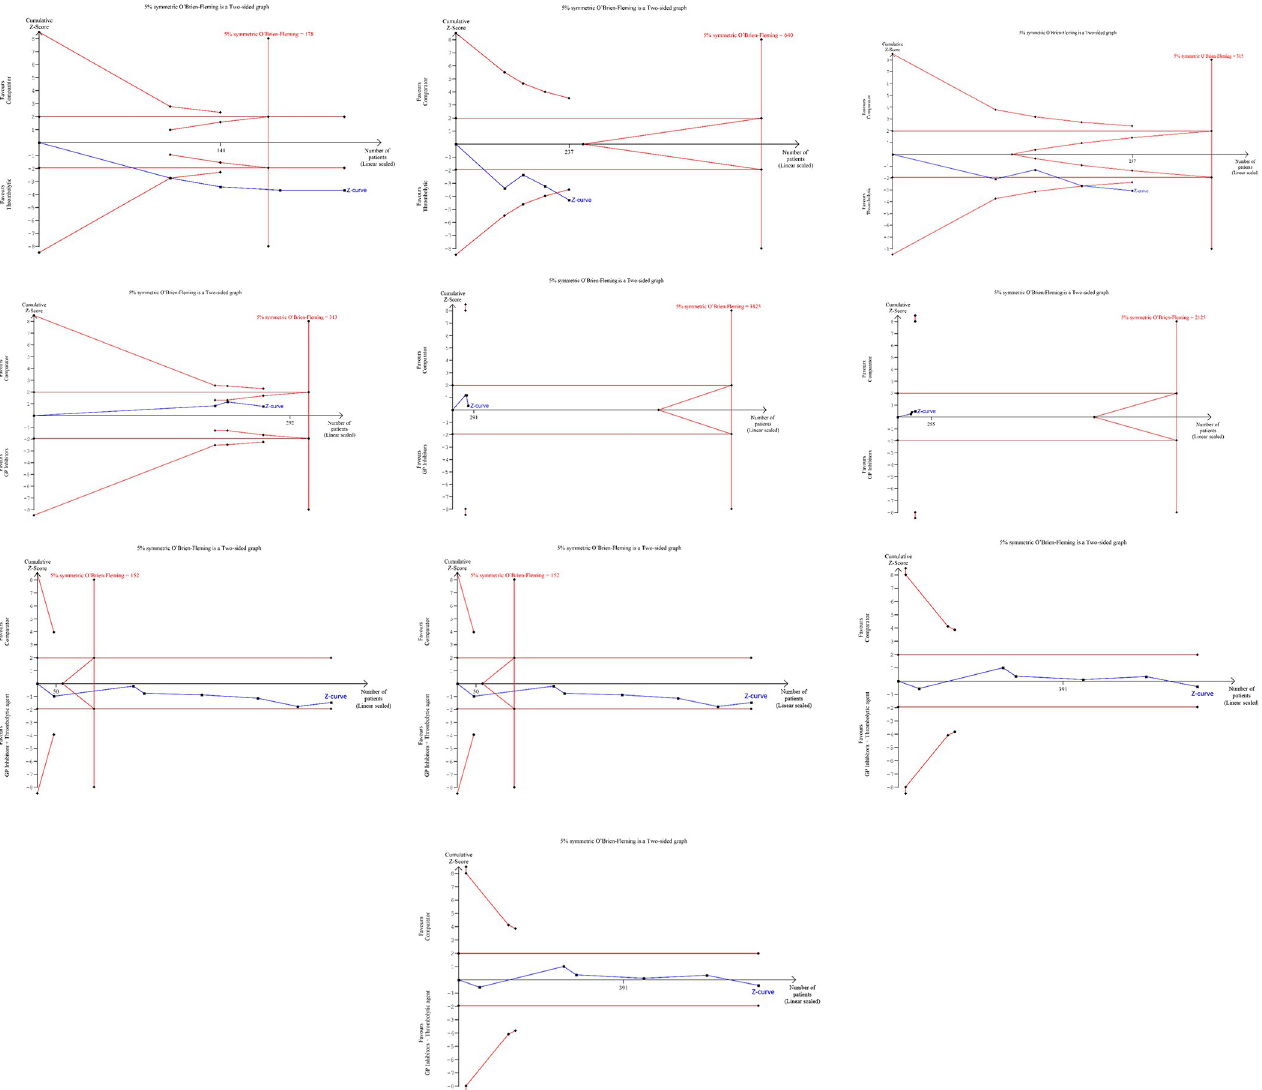
Fig 7. Trial sequential analysis for procedural outcomes. MBG, myocardial blush grade; STR, ST-segment resolution; TMPG, TIMI myocardial perfusion grade.